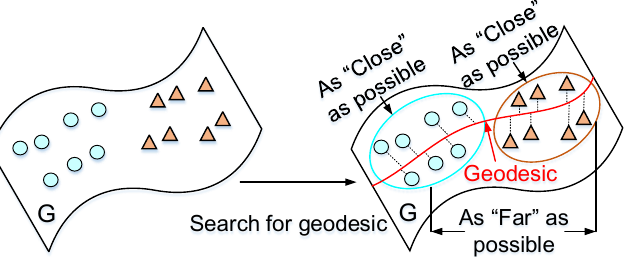
Figure 11. The principle of searching for geodesic in Lie Group (G) manifold